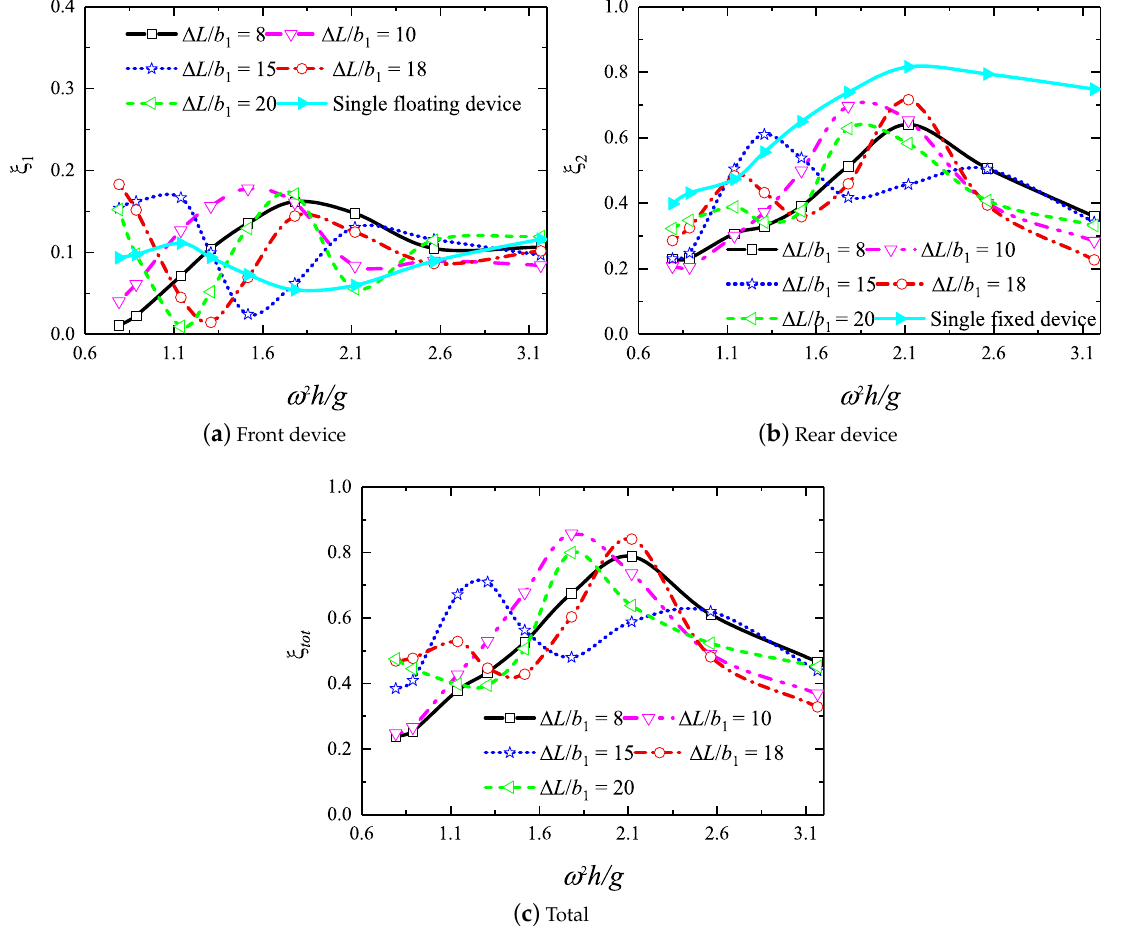
Figure 18. Effects of the long intervals on the hydrodynamic efficiencies. In all cases, b 2 / b 1 = 2, d 1 = d 2 = d 3 = 0.05 m, and K =